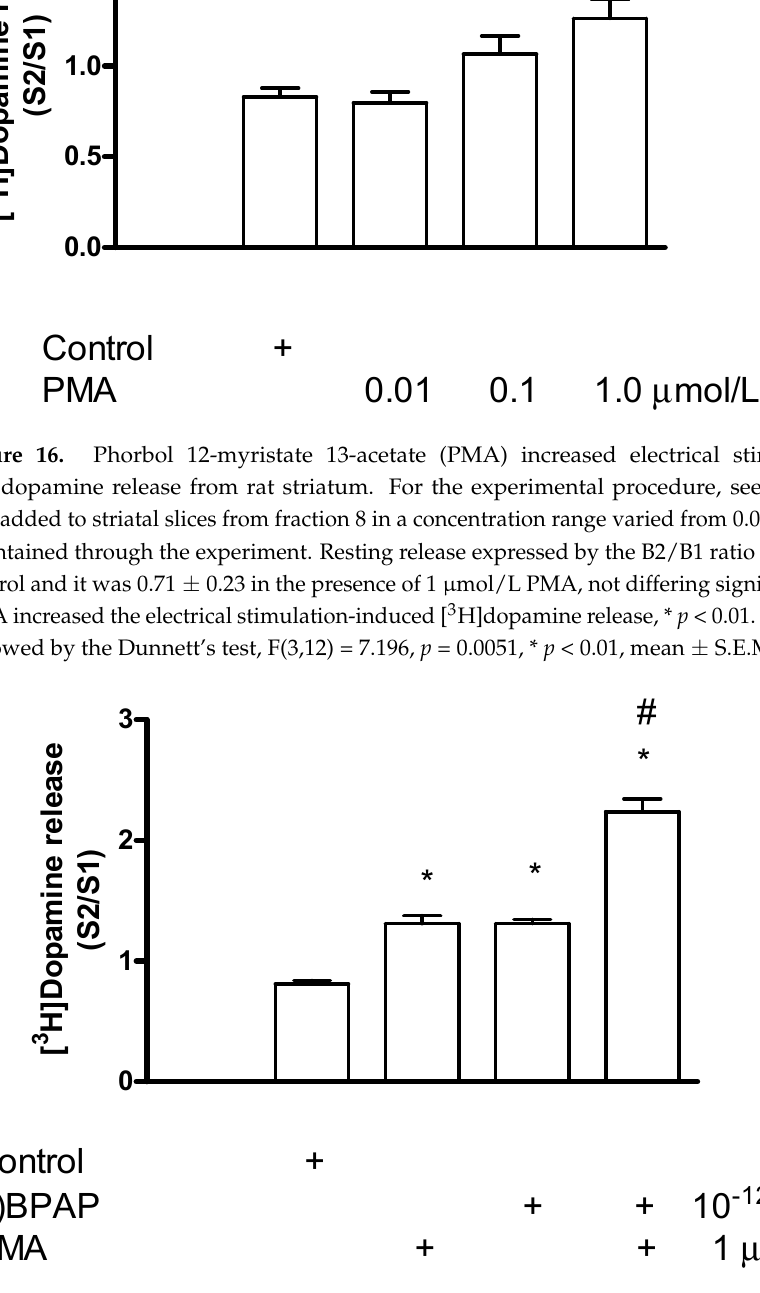
Figure 17. Phorbol 12-myristate 13-acetate (PMA) potentiated the ( − )BPAP-stimulated [ 3 H]dopamine release in rat striatum. For the experimental procedure, see Figure 2A. ( − )BPAP was added to striatal slices from fraction 8 in a concentration of 10 − 12 mol/L. PMA was added to striatal slices from fraction 12 at a concentration of 1 µ mol/L, and drugs were maintained throughout the experiment. One-way ANOVA followed by the Dunnet’s test, F(3,28) = 82.75, p < 0.0001, * p < 0.05.